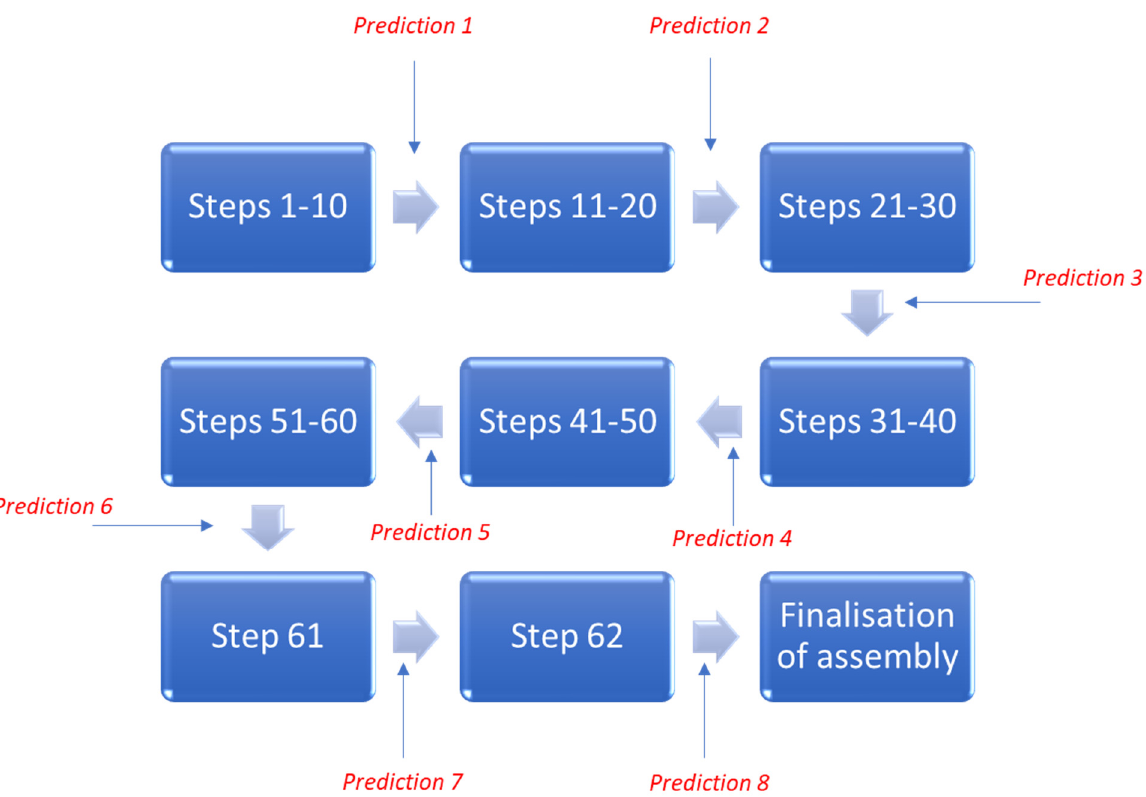
Figure 8. Assembly process flow and identification of crucial steps of the process.